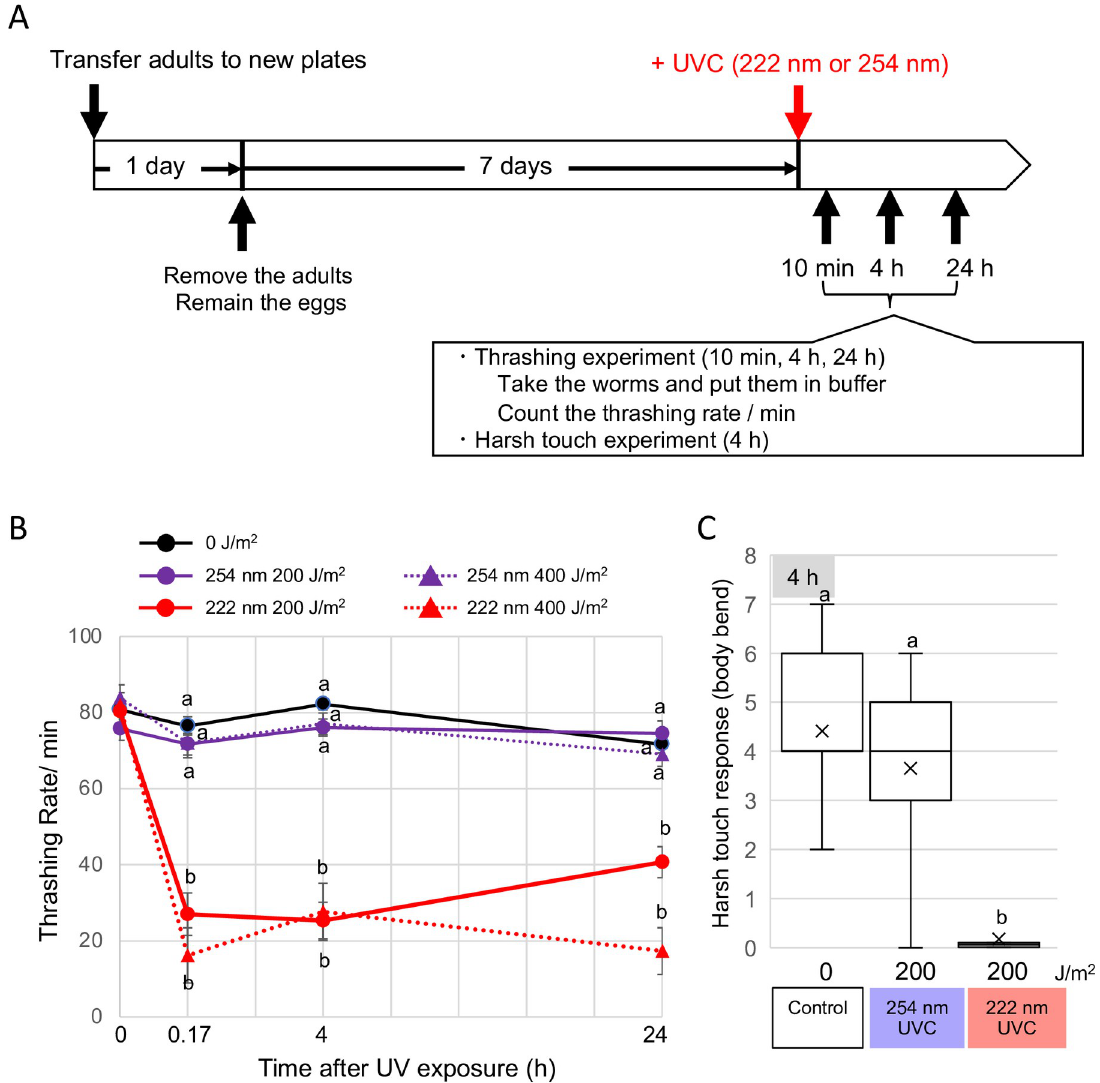
Fig 3. Effects of 254- or 222-UVC exposure on C . elegans motility. (A) Schematic cartoon of experimental design. Transferred five adults to new NGM plates seeded with Escherichia coli . One day later, removed the adults and remained eggs. 7 days later, took the adult worms and put them into PBS buffer and counted the thrashing number per minute. (B) The number of thrashes in 1 min was counted for each worm ( n = 10–28 worms) at 0 min, 10 min, 4 h, and 24 h after UVC exposure. The purple line and red line indicate the thrashing rate of 254-UVC and 222-UVC irradiated worms, respectively. Colored solid and dotted lines indicate 200 and 400 J/m 2 irradiation, respectively. Error bars indicate the SE for 10–28 worms. a and b indicate a significant difference between indicating two groups (one- way ANOVA followed by Dunnett’s method) ( P < 0.05). (C) Harsh touch responses of WT animals. After 4 h from UVC exposure, response was assayed as the number of reverse body-bends a worm makes following a harsh touch stimulus to the head. Box plots show minimum, 25th percentile, median, 75th percentile, and maximum. Inside line and x indicate the value of median and average, respectively. a and b indicate a significant difference between indicating two groups (one-way ANOVA followed by Dunnett’s method) ( P <